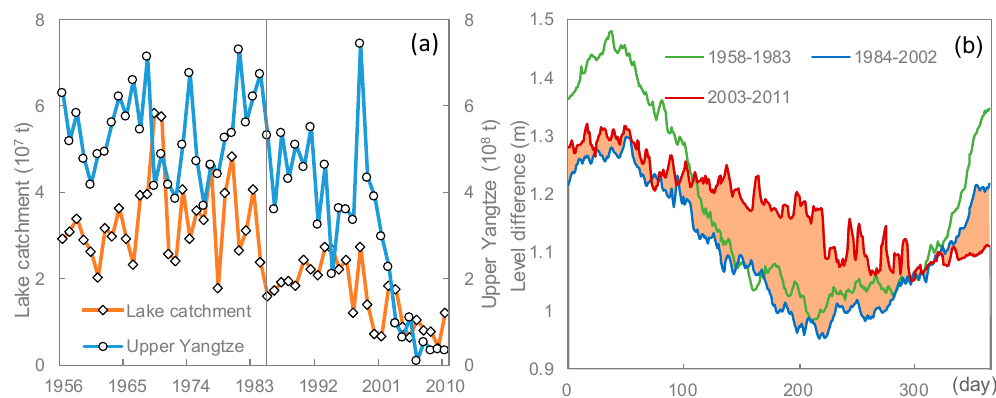
Figure 5. The changes of sediment transport from the lake catchment and the Upper Yangtze ( a ), and long-term evolution trend of the water level difference downstream the outlet of the lake ( b ).